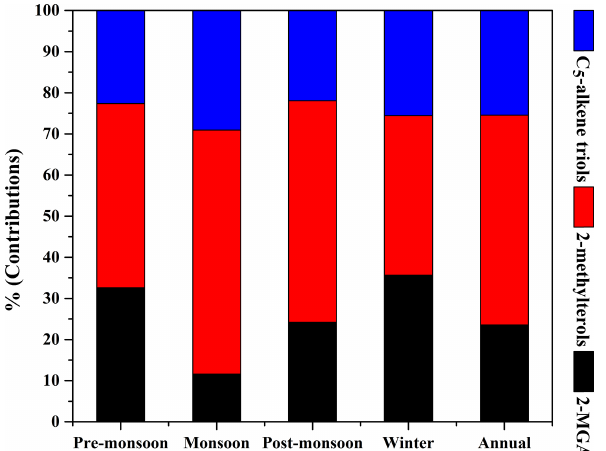
Figure 7. Ratios of 2-MGA / 2-MTLs during different seasons in Bode,